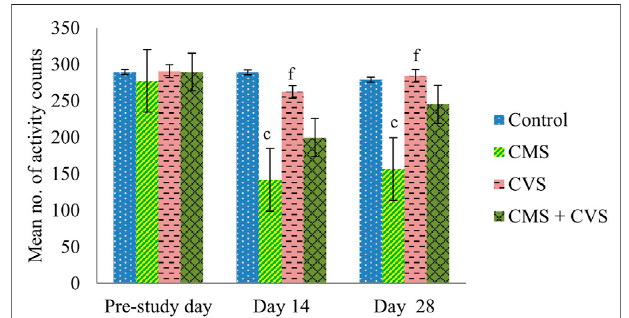
FIGURE 3 | Effect of CVS on wire grip. Values are expressed as mean ± SEM ( n = 6). a p < 0.05, c p < 0.001 compared with that of control group; e p < 0.01, f p < 0.001 compared with that of CMS group. (One-way ANOVA followed by Tukey ’ s post hoc test).